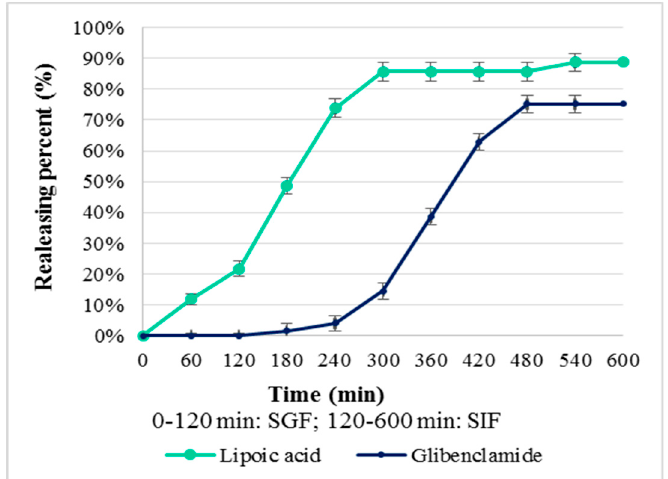
Figure 9. Releasing percent (%) from CS–Gly–LA system.